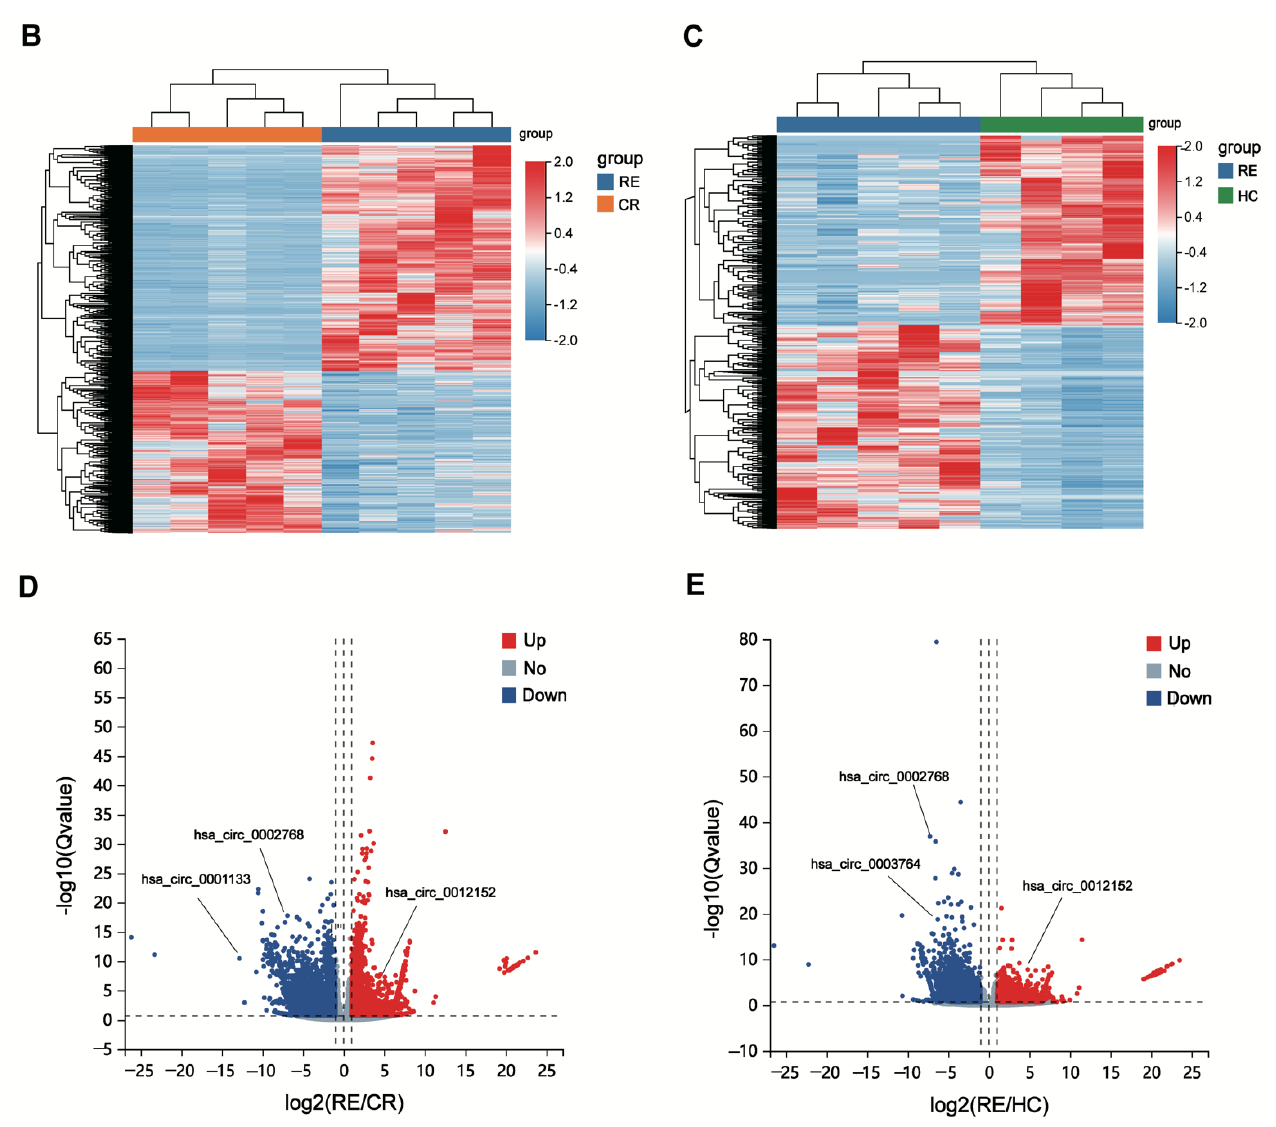
Figure 2. CircRNA expression is altered in AML relapse (RE) compared with controls (CR or HC). ( A ) The Venn diagram (left) and UpSet plot (right) show that numbers of DE circRNAs among the different groups. ( B , C ) The heatmaps show the DE circRNAs from unsupervised hierarchical clustering present in AML patients with relapse versus remission ( B ) and relapse versus healthy controls ( C – E ). Volcano plot graphs for circRNAs expression levels in patients with relapse versus remission ( D ) and relapse versus healthy controls ( E ) Red indicates an upregulated expression and blue represents a downregulated